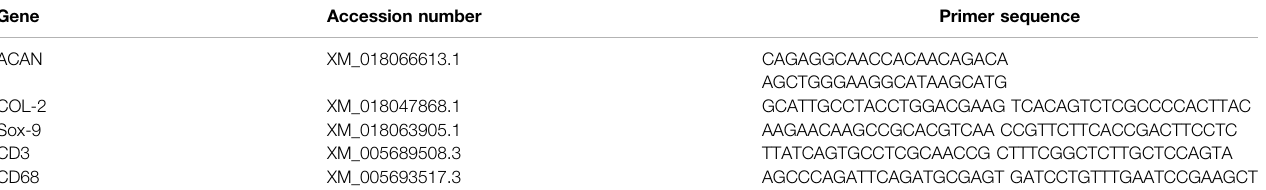
TABLE 1 | Primer sequences of related genes.